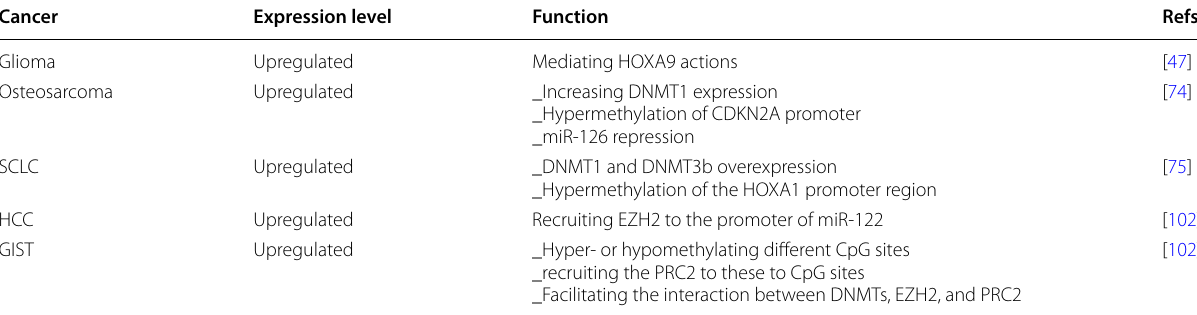
Table 1 HOTAIR expression level and function in different cancers Cancer Expression level Function Glioma Upregulated